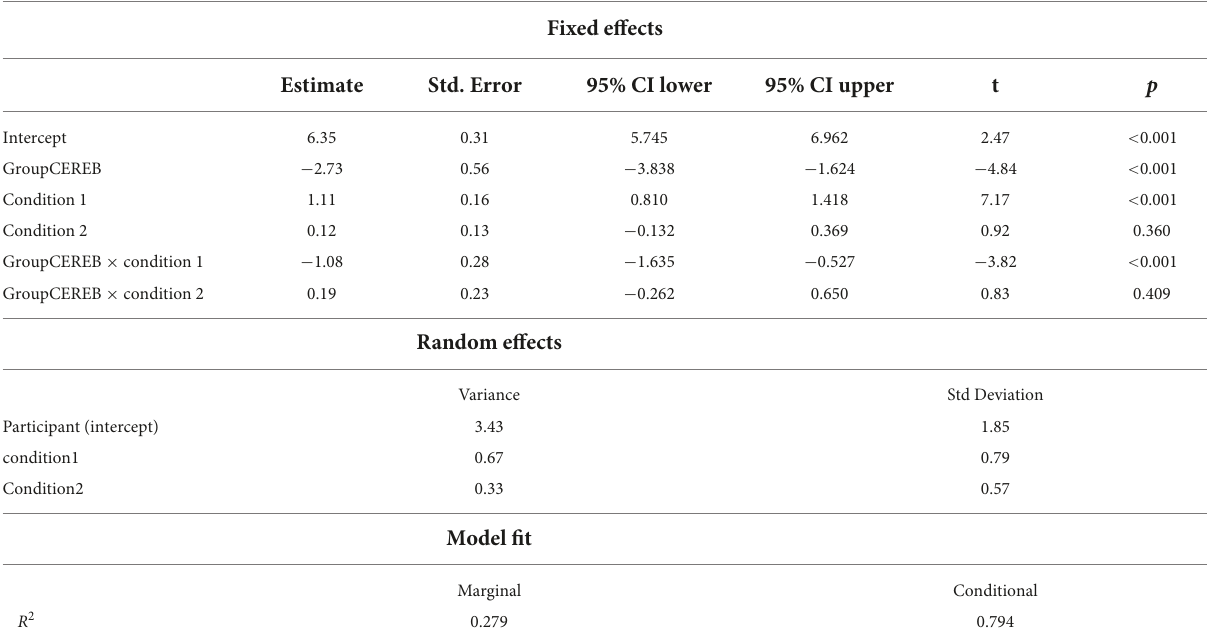
TABLE 2 Summary of the final Linear Mixed Model for the melodic reproduction task